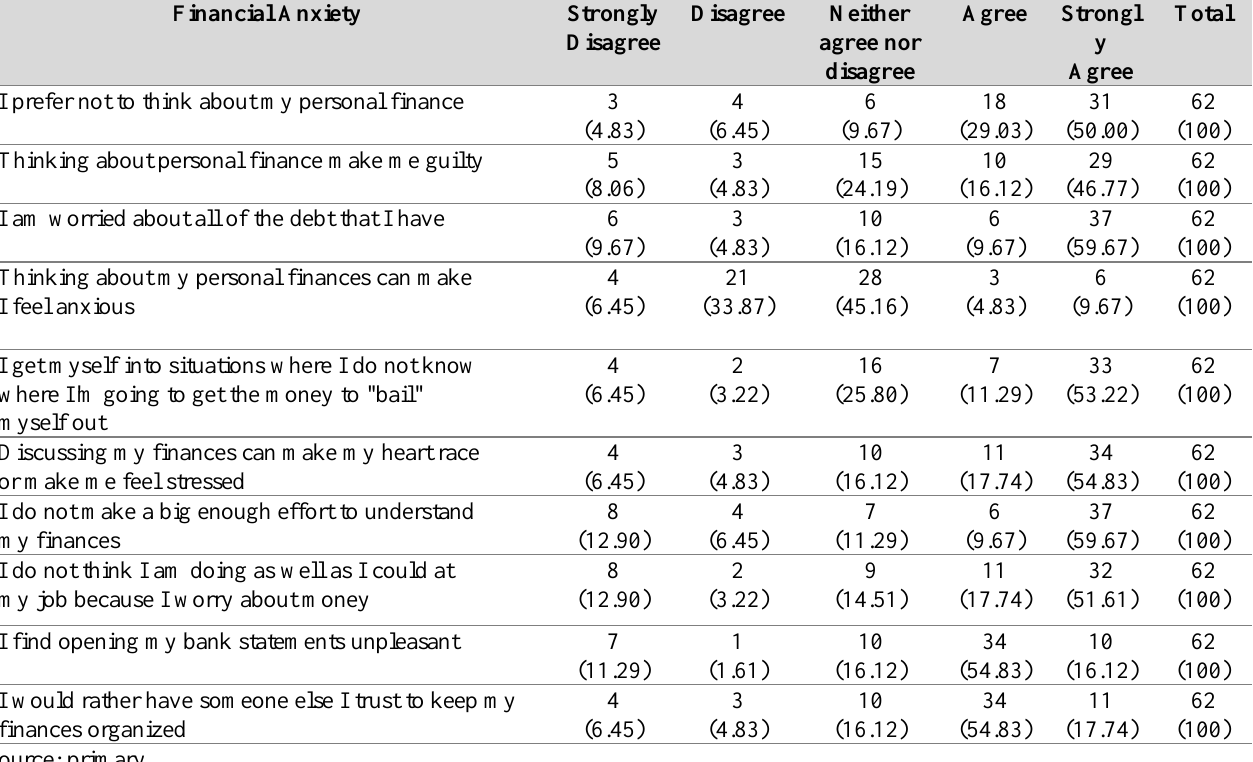
Financial Anxiety Assessment of the